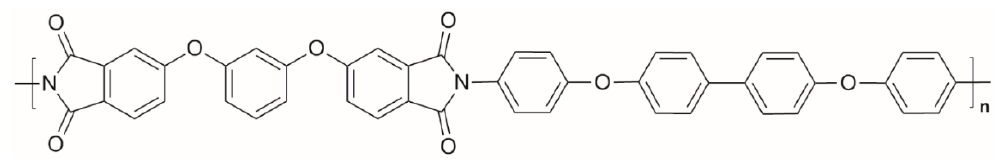
Figure 1. Structure of the R-BAPB elementary unit.